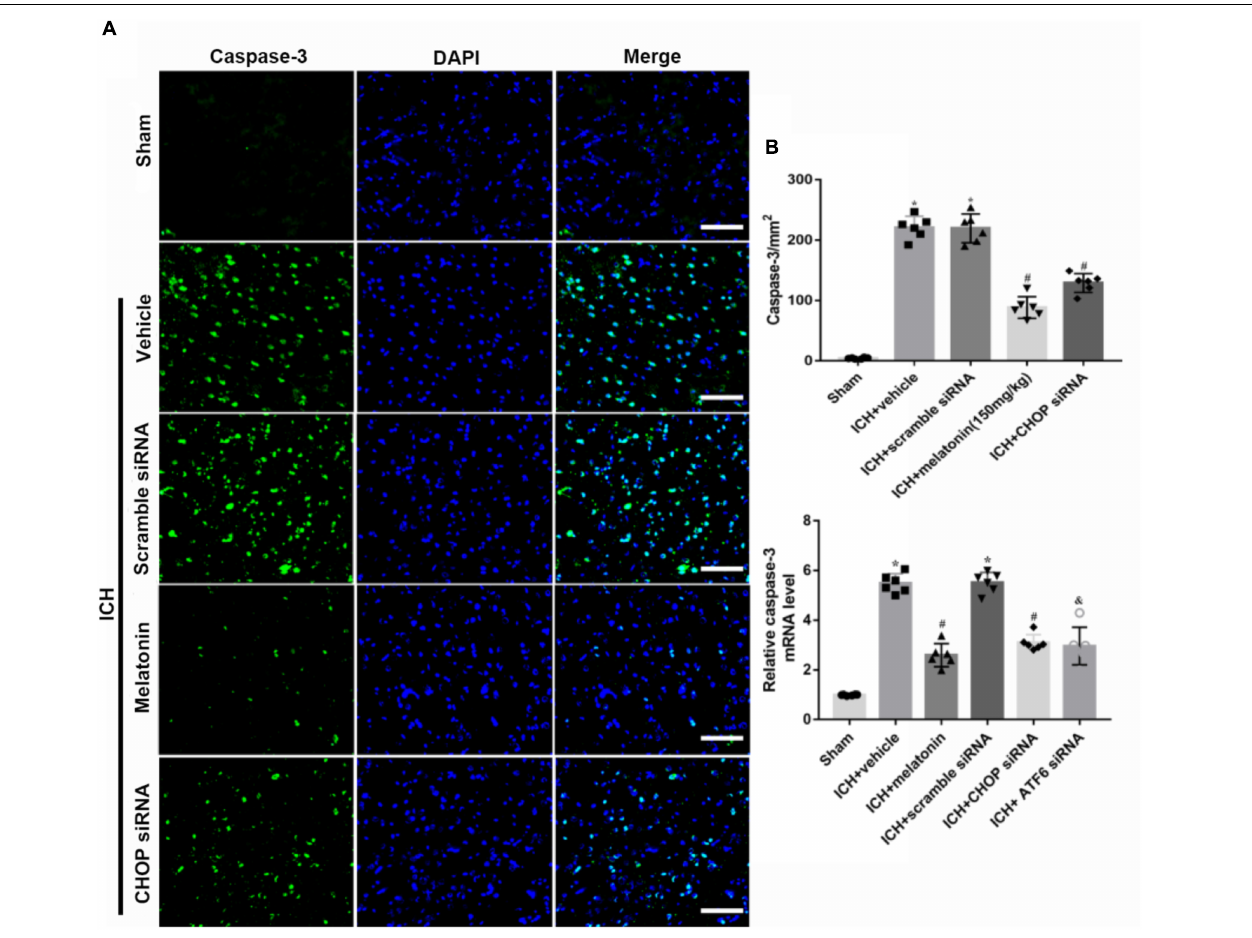
FIGURE 5 | The administration of melatonin significantly decreased the number of caspase-3 and DAPI double-stained cells in the perihematomal region 24 h after ICH. (A) Representative microphotographs showed the co-localization of DAPI (blue) with caspase-3 (green)-positive cells in injured brain hemisphere at 24 h after ICH; (B) quantitative analysis of caspase-3 positive cells showed that melatonin decreased the number of apoptotic cells after